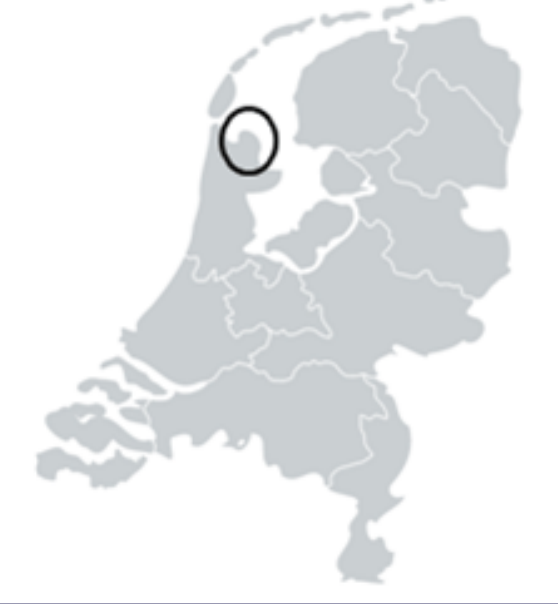
Fig. 1 . Map of the Netherlands with the Wieringermeer